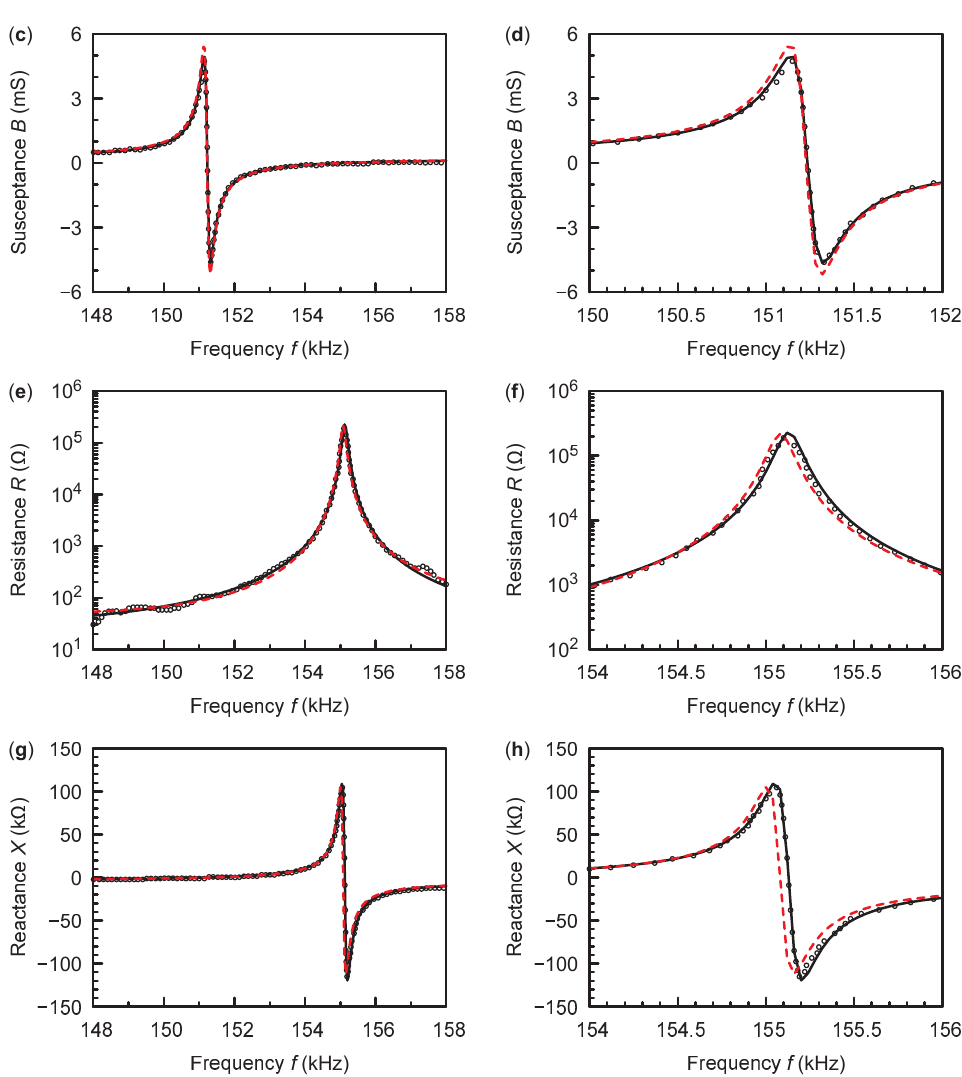
Figure 3. The measured and best fitting admittance and impedance of the hard PZT. ( a , b ) Conduc- tance. ( c , d ) Susceptance. ( e , f ) Resistance. ( g , h ) Reactance. ( b , d , f , h ) are the close-up views of ( a , c , e , g ), respectively. The red dashed lines represent the best fitting admittance and impedance calculated in